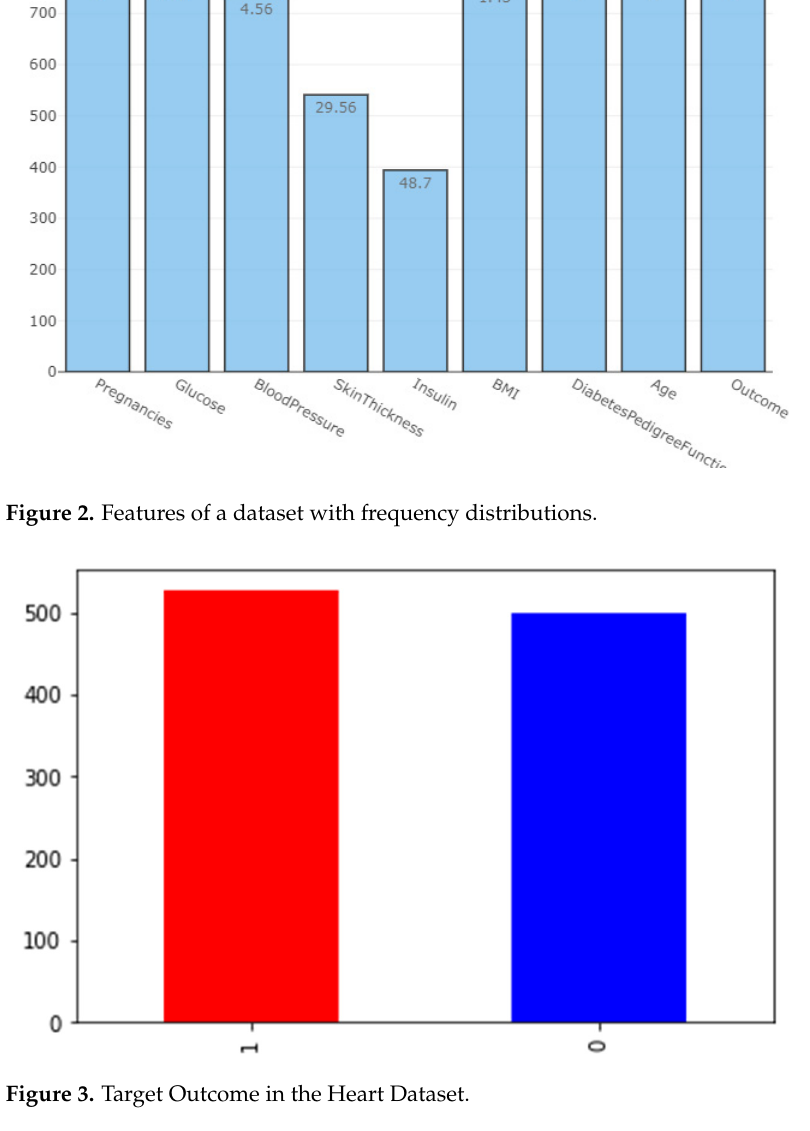
Figure 3. Target Outcome in the Heart Dataset .